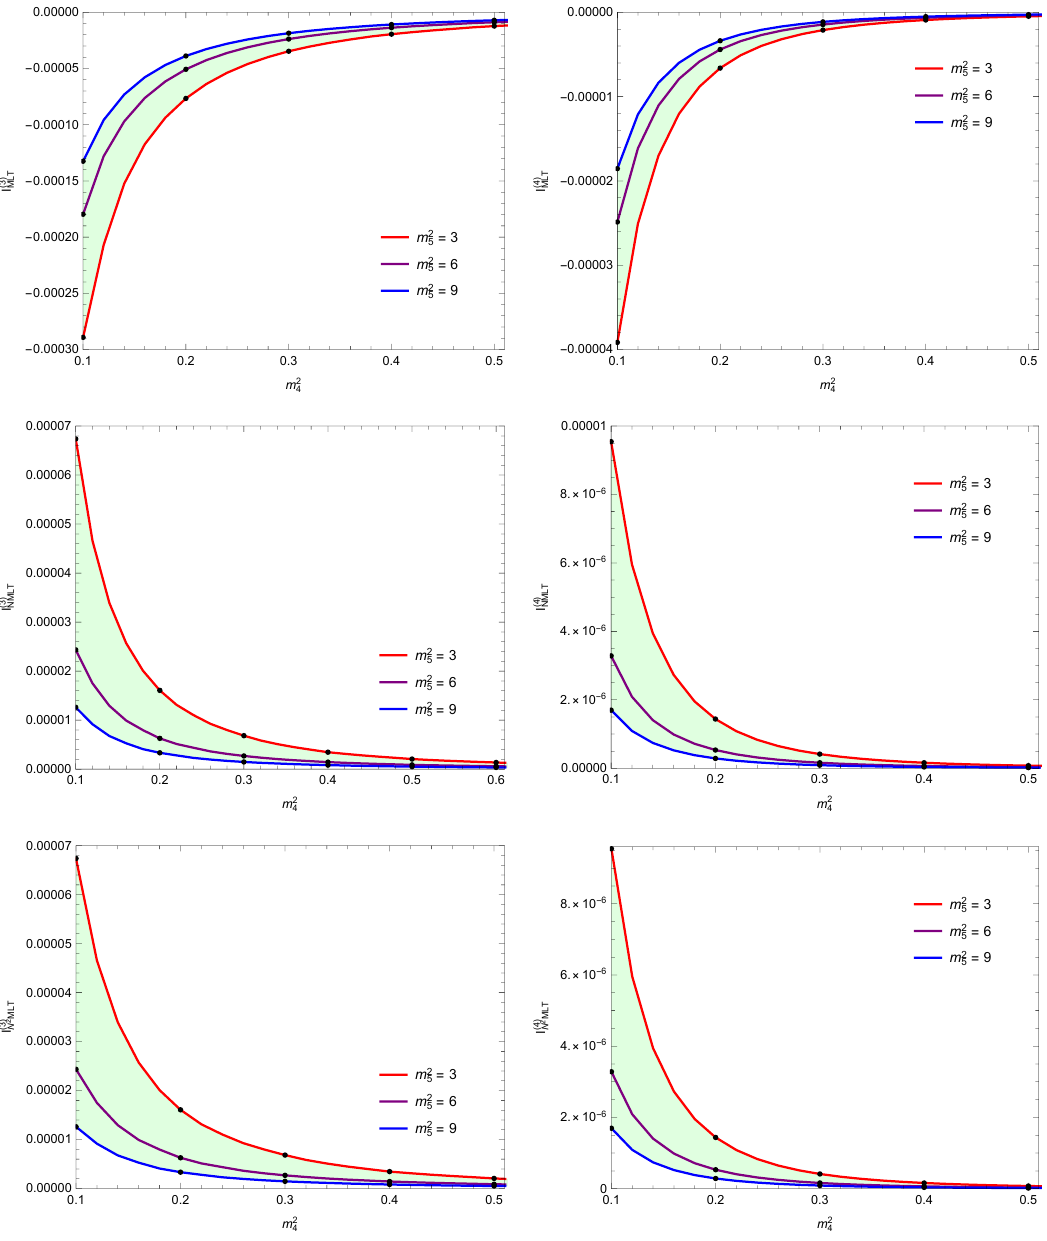
Figure 8 . Three-dimensional MLT, NMLT and N 2 MLT at three and four loops, as a function of the internal masses m 2 and m 2 . Solid lines correspond to the analytic results of LTD and dots to 4 5 the numerical results of Fiesta 4.2